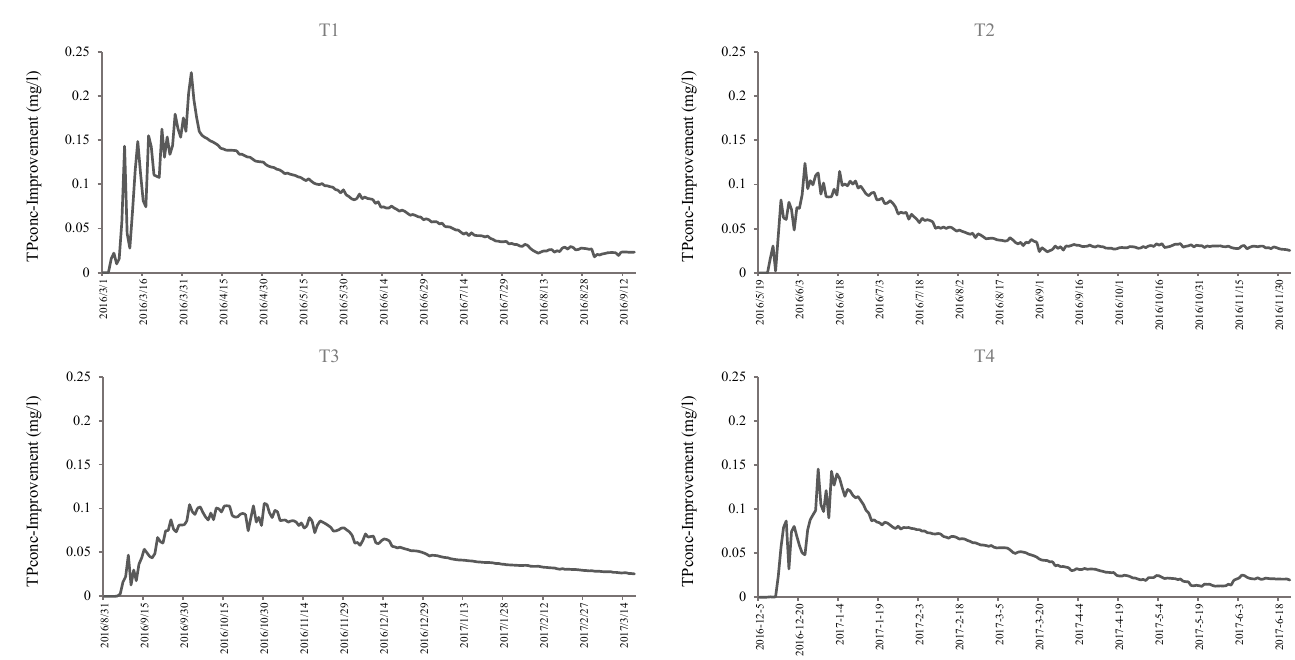
Figure 8. Response curve for each season with other parameters equal (base0, A0, 300 t/d).